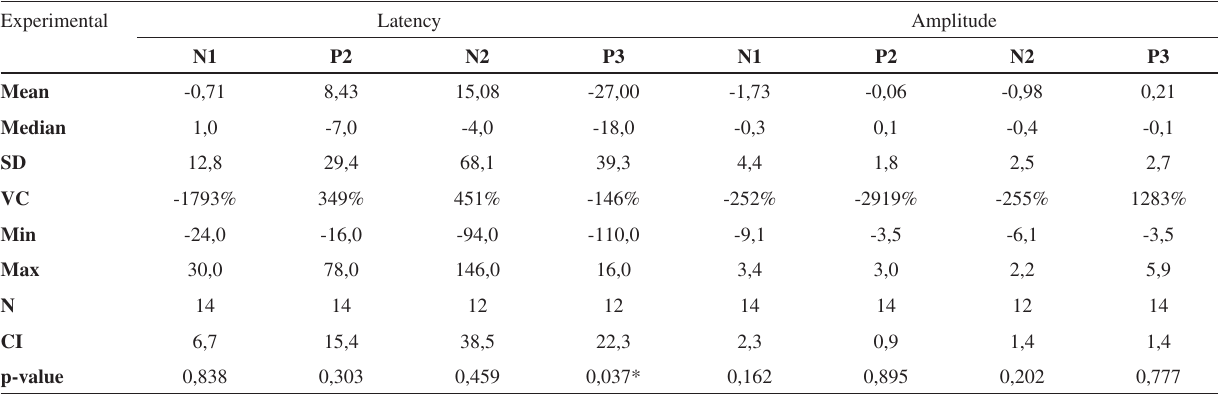
Table 5 - Variation in latency and amplitude values of LLAEP for the experimental group when comparing pre- and post- training